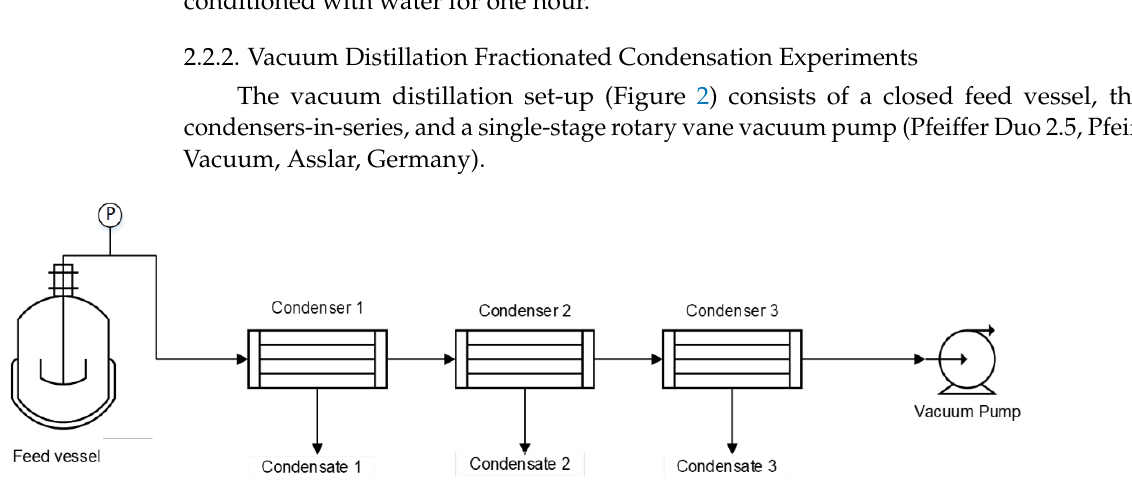
Figure 2. Experimental vacuum distillation-fractionated condensation laboratory set-up. p is the pressure transducer.